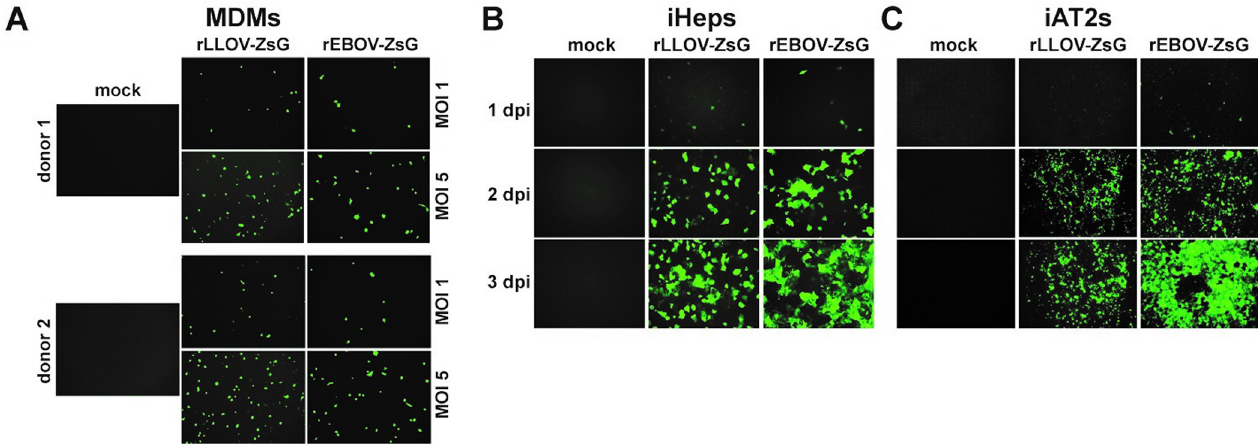
Fig 4. Cellular tropism of rLLOV comp . (A) Infection of MDMs derived from 2 donors with the indicated MOIs of rEBOV-ZsG and rLLOV-ZsG-IR ins - EBOV UTR+tr , labeled rLLOV-ZsG. Fluorescent images taken at 2 dpi. Infections of (B) iPSC-derived hepatocytes (iHeps) or (C) iPSC-derived lung alveolar type 2 cells (iAT2s) with rEBOV-ZsG or rLLOV-ZsG at an MOI of 1. Images were taken with 10x objective.